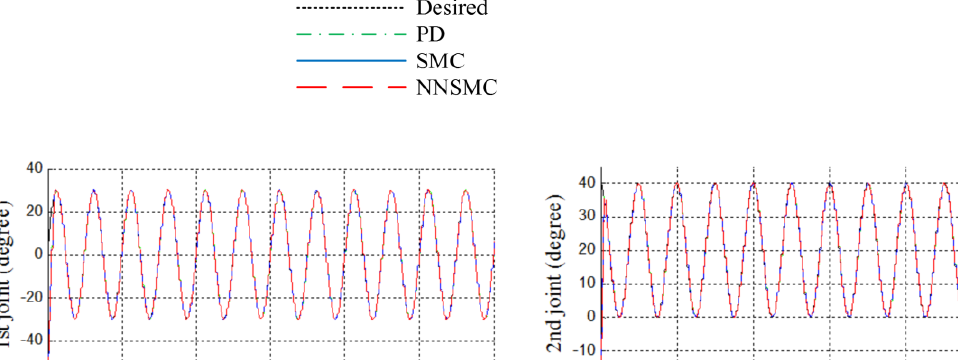
Figure 11. The hardware setup for the 3-DOF manipulator.